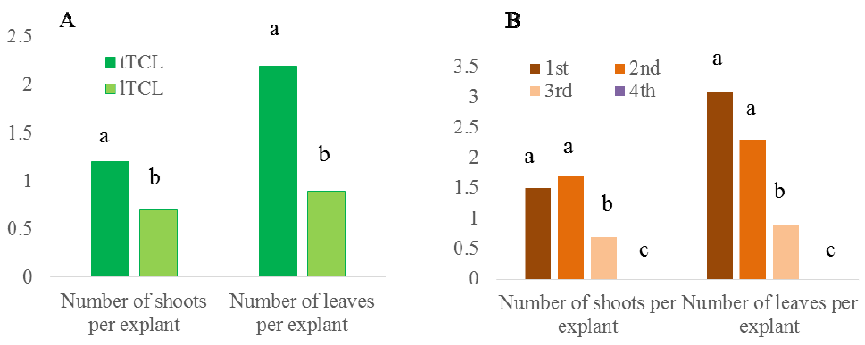
Fig. 1. Effect of TCL types and slicing positions on shoot initiation. A. Effect of TCL types on shoot initiation, B. Effect of slicing positions on shoot initiation. Histograms followed by the same letter in the same cluster are not significant different based on Tukey test, p=0.05. Table 1. Interaction effect of TCL types and slicing positions on number of shoots per explant TCL type